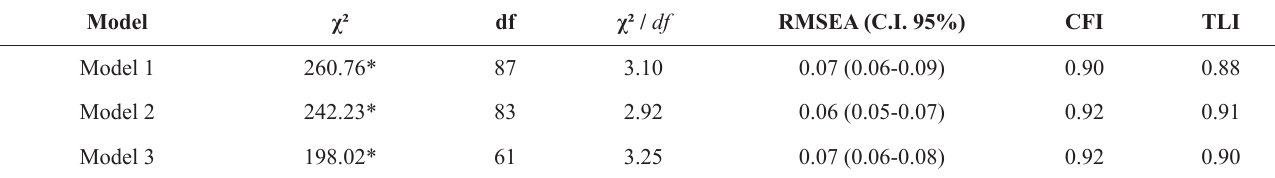
Table 1 - Goodness-of-fit indexes of the 3-factor model of the Brazilian version of the ABQ. Model